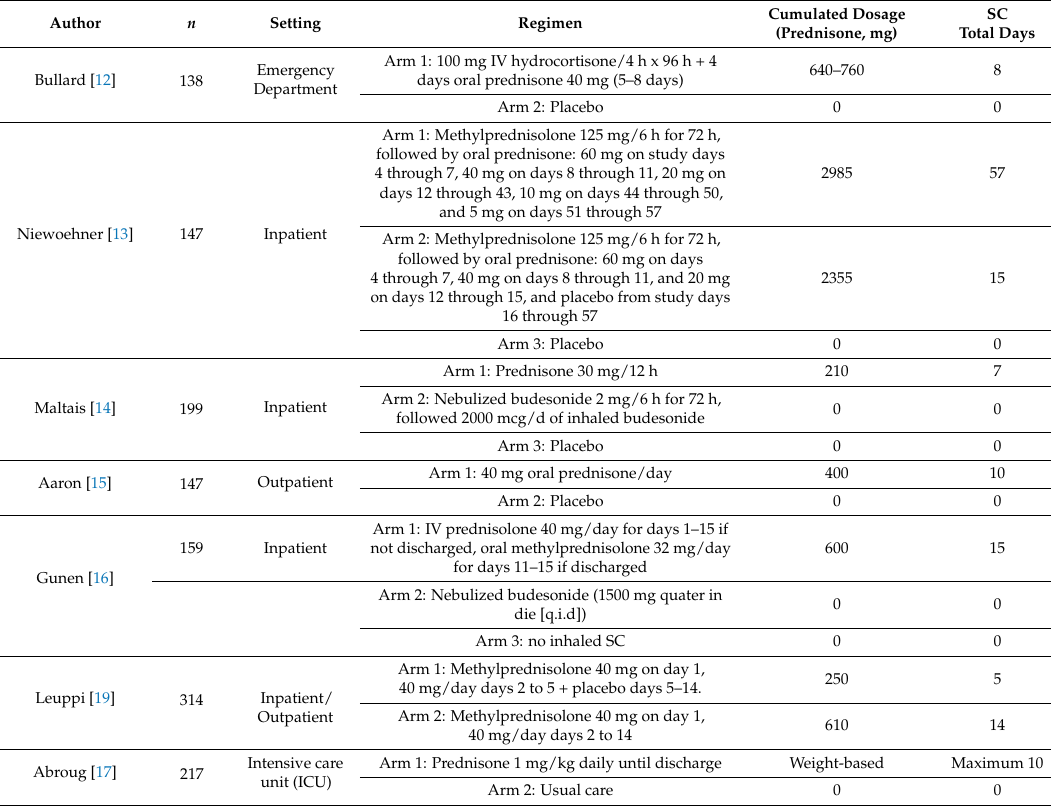
Table 1. Most relevant studies regarding the efficacy of systemic corticosteroids